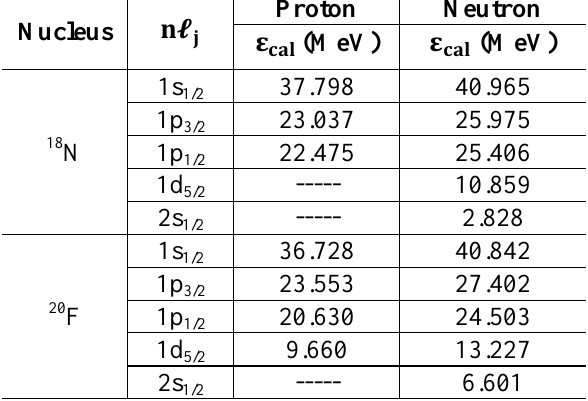
Table 4: The calculated ε for the selected halo nuclei.